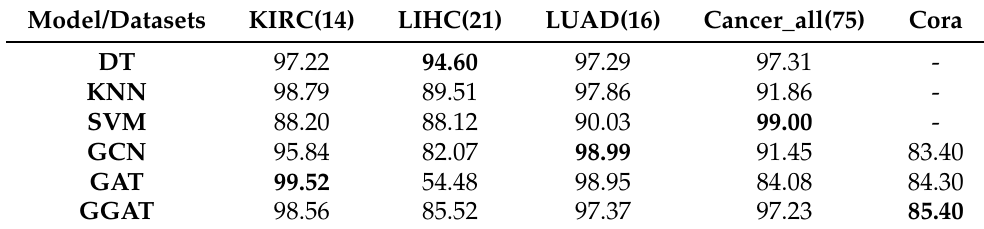
Table 5. Accuracy of Models Under Optimal Feature Dimensions.